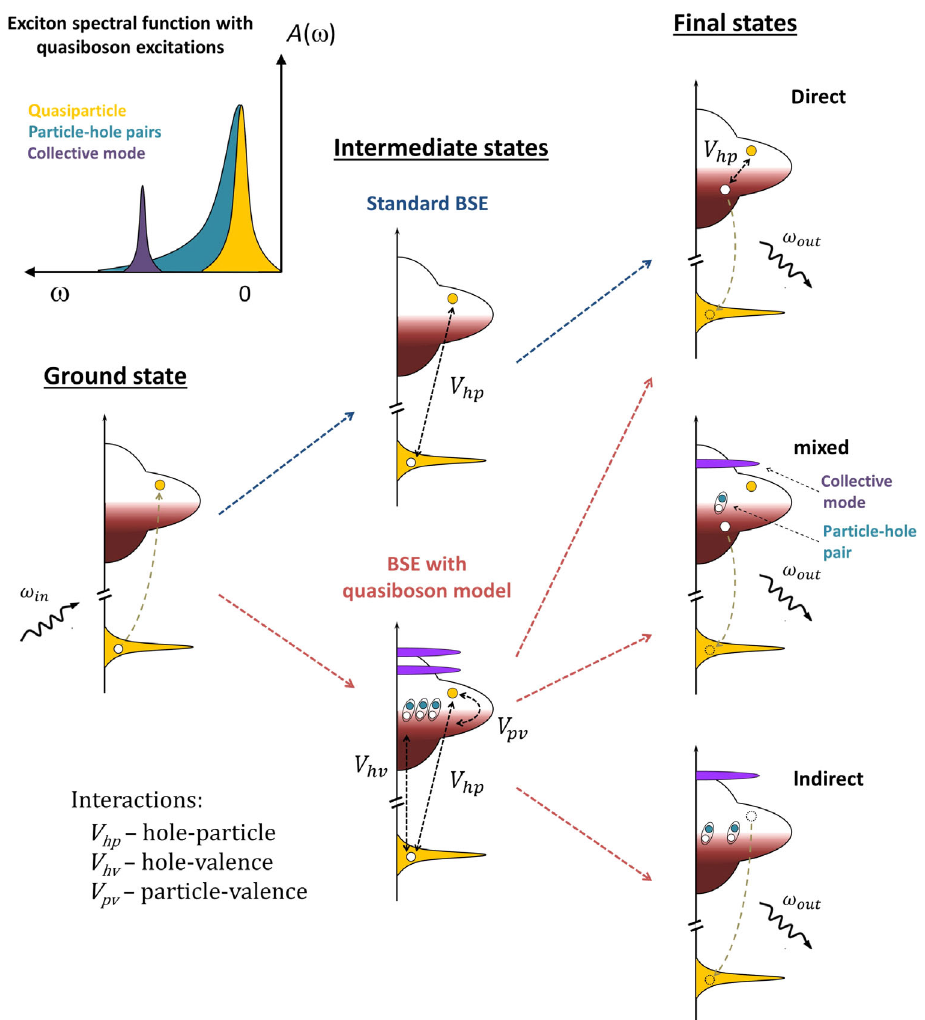
FIG. 6. Schematic diagram of the RIXS process within the standard BSE evaluation of the Kramers-Heisenberg formula (blue channel) and the BSE combined with a quasiboson Hamiltonian to describe secondary excitations of the valence levels (red channel). The standard BSE approach includes a screened interaction between the hole and photoelectron ( V states but neglects explicit generation of additional excitations and, consequently, accounts for only pure direct RIXS processes. Combining the BSE with a quasiboson model that contains additional hole-valence ( V in the intermediate state implicitly incorporates secondary excitations, allowing calculations to additionally generate indirect RIXS processes and mixed direct-indirect events. The top-left decomposes the effective exciton spectral function A ð ω Þ into quasiparticle (yellow), particle-hole pairs (cyan), and collective modes